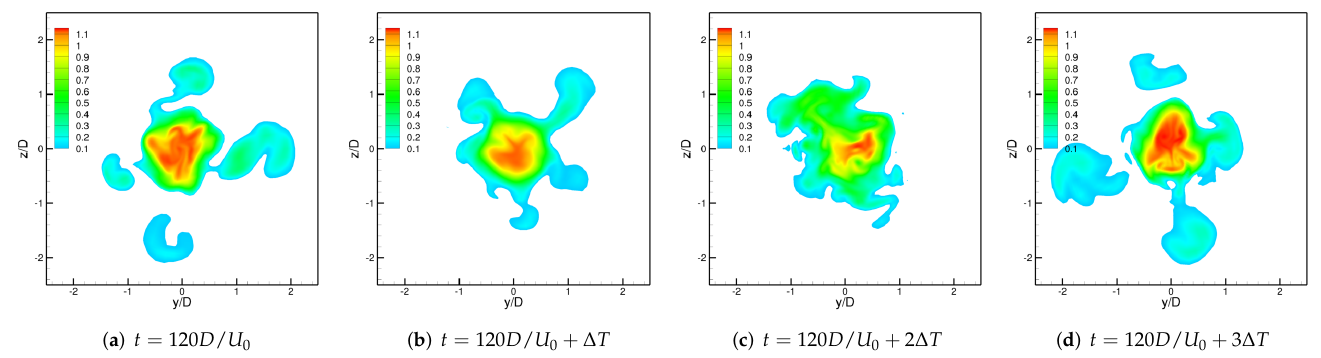
Figure 12. Contours of an instantaneous axial velocity U x / U 0 at the plane perpendicular to the jet axis x / D = 9 for the case E − Cyl − Ti 0.01 .